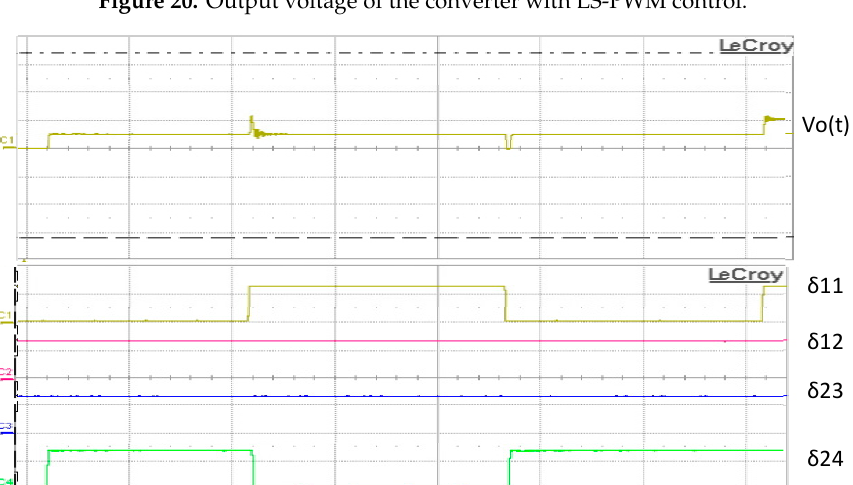
Figure 21. Output voltage V o (t) and switching patterns sent to T11, T12, T23, and T24 (ZOOM 1 in Figure 20).